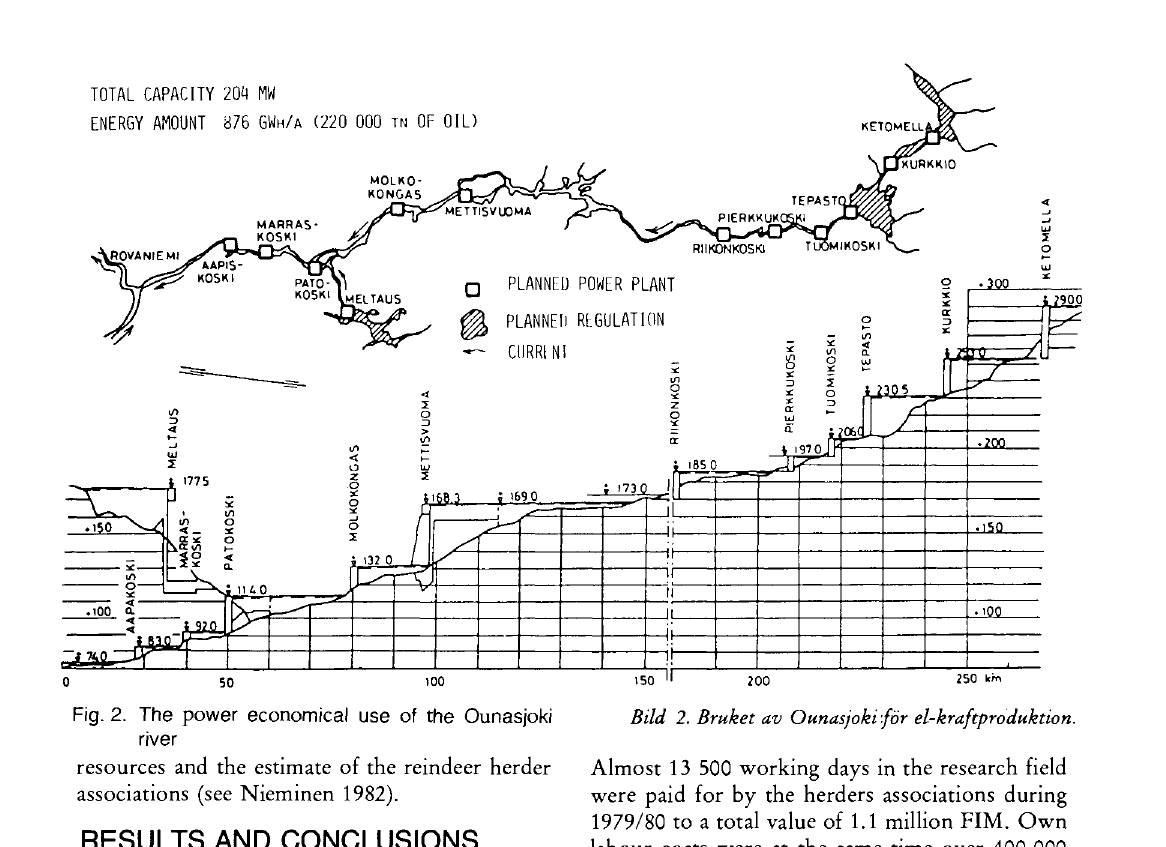
Fig. 2. The power economical use of the Ounasjoki river resources and the estimate of the reindeer herder associations (see Nieminen 1982).